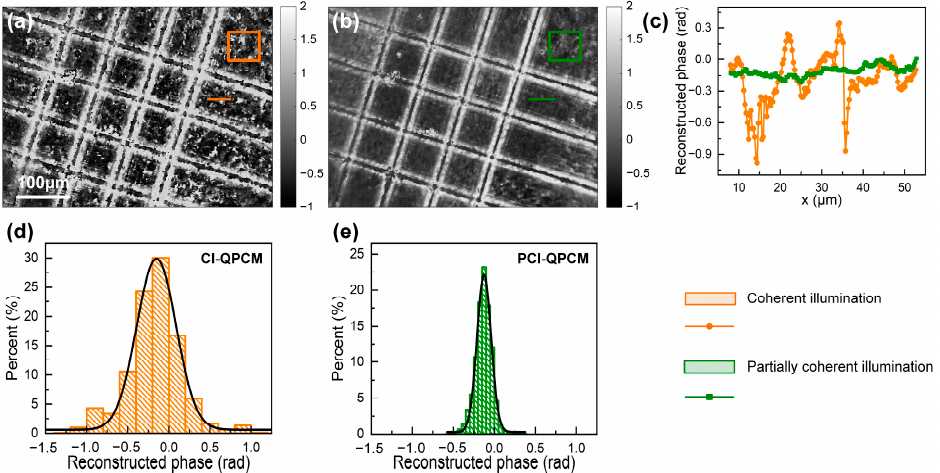
Figure 5. The comparison of speckle-noise between CI-QPCM and PCI-QPCM. ( a , b ), The phase images of a transparent waveguide obtained by CI-QPCM and PCI-QPCM, respectively. ( c ) The phase profiles along the orange/green lines in ( a , b ). ( d , e ), The histograms of the phase values within the orange and green boxes in ( a , b ).